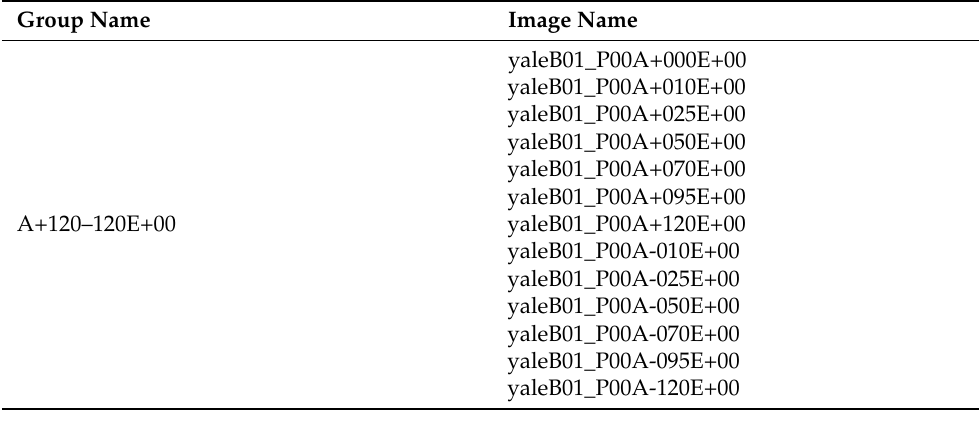
Table 3. List of images grouped in one of 7-groups (group-A+120–120E+00).